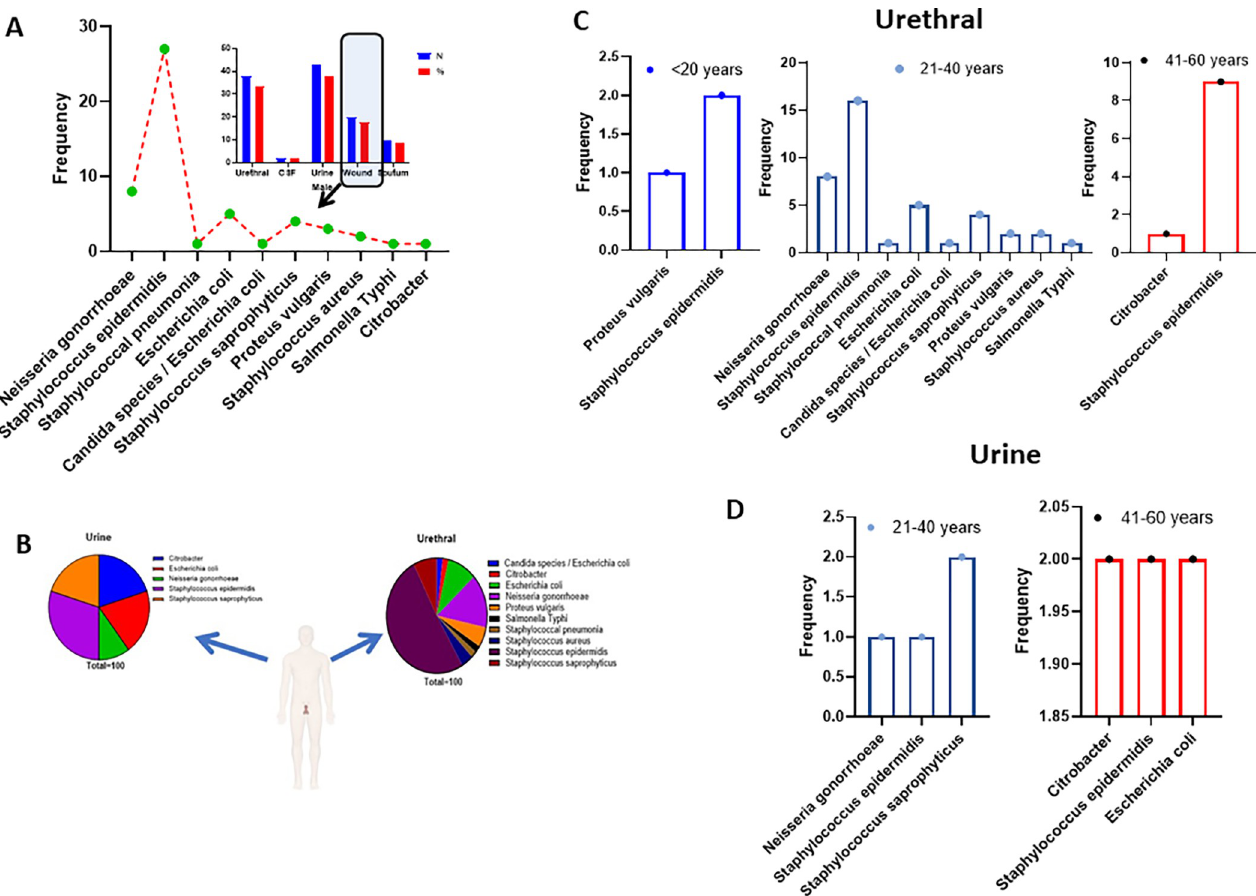
Fig 2. High isolation of multiple antibiotic-resistant E . coli from urethral swab among male patients between 21–40 years of age. A. The frequency of different bacteria isolates from urethral swab samples. 50.94% of the isolates were Staphylococcus epidermidis , 15.09% were Neisseria gonorrhoeae and 9.43% Escherichia coli being the third-highest bacteria isolates from the male urethra. B. Pie charts showing the various % frequencies of bacteria isolated from the different specimens collected from male patients attending UCC hospital. Escherichia coli were only isolated from urethral swabs (9.43%) and urine (20%) among the respective bacteria isolates from each specimen. C. The interleaved bars showing frequencies of bacteria isolates from Urethral swabs samples from male patients across the age categories � 20 years, 21–40 years and 41–60 years. D. The interleaved bars show frequencies of bacteria isolates from urine samples across the age categories 21–40 years and 41–60 years. No bacteria isolates were obtained among the age � 20 years.